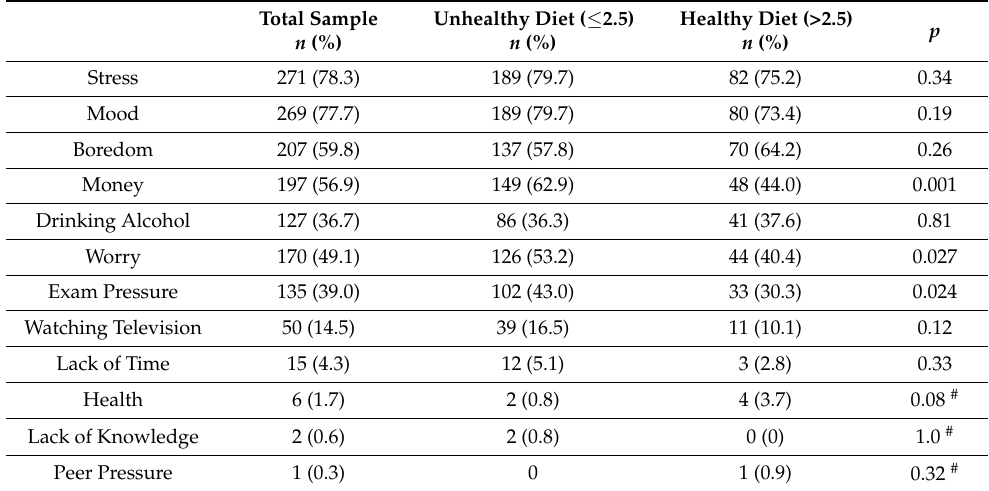
Table 2. Factors influencing dietary